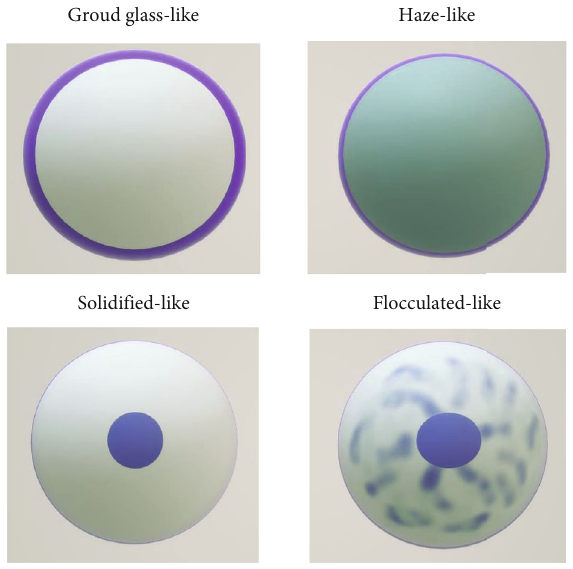
Figure 1: Patterns of four special nuclear